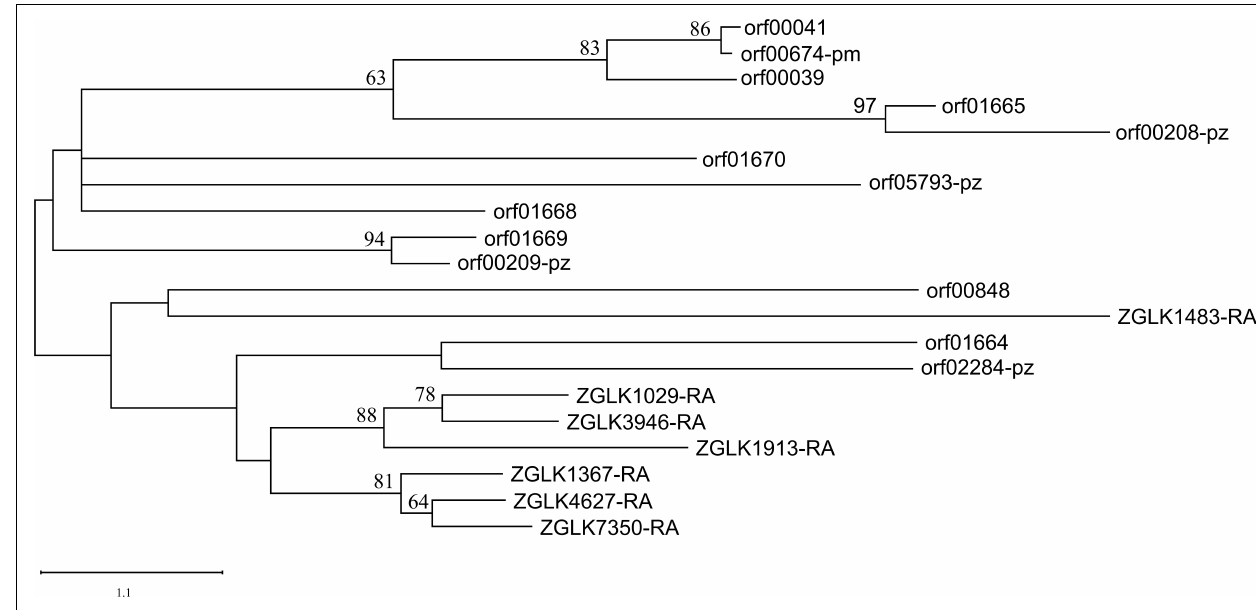
FIGURE 4 | Phylogenetic placement of the endobacteria inferred by maximum likelihood phylogenetic analysis based on 20 Subtilases/peptidase S8 amino acid sequences (ZGLK, fungi gene; orf, bacteria gene). The 20 genes used for the phylogenetic analysis are listed in Supplementary Table 12 .